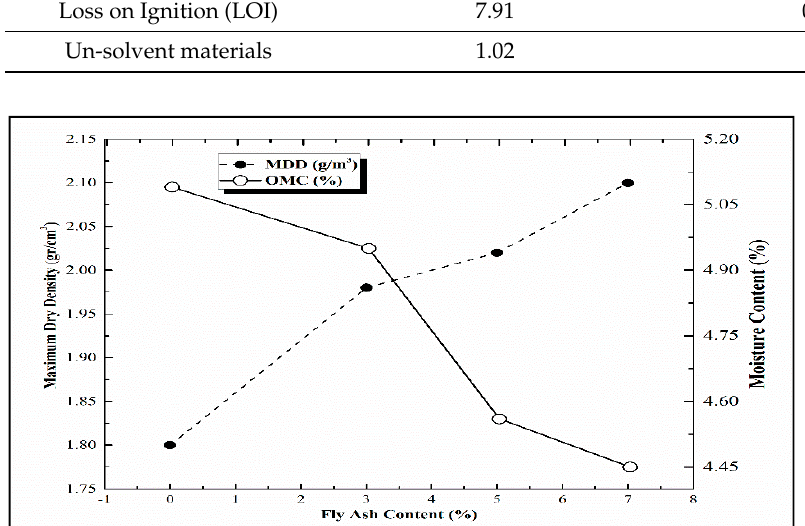
Figure 3. Effect of FA on the compaction of cement-modified desert soil (30:70).